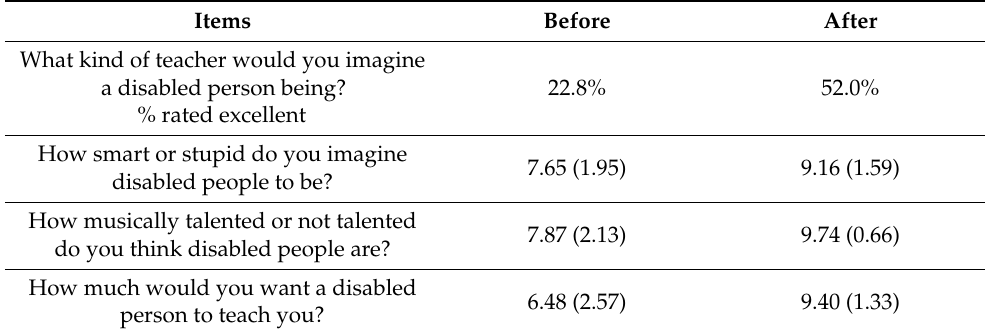
Table 3. The means and (SDs) given to the mentors with disabilities. Items Before After What kind of teacher would you imagine a disabled person